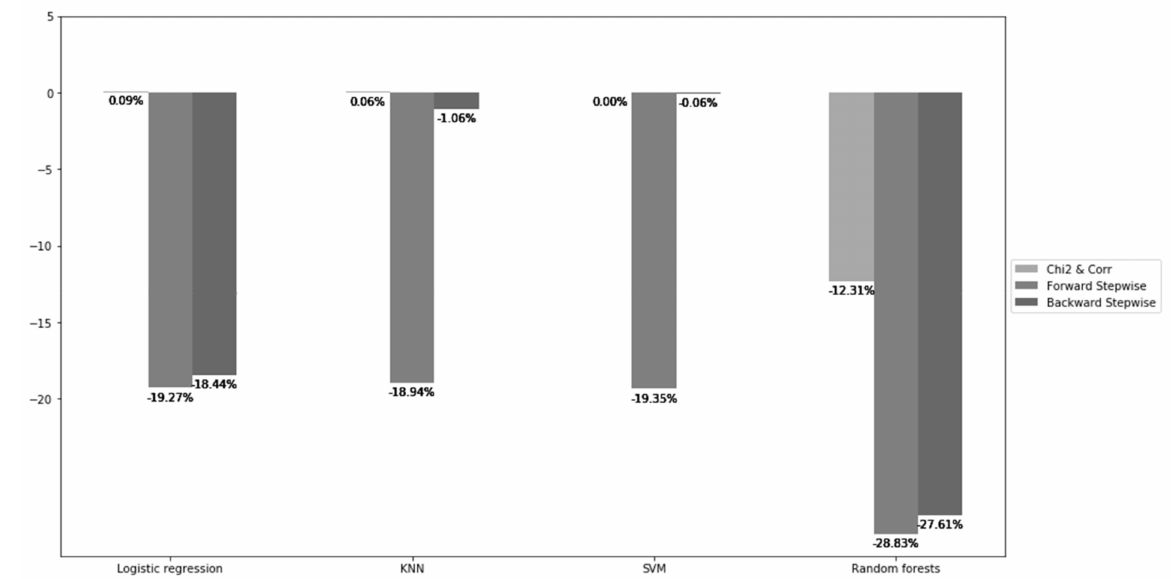
Figure 7. The change in MAE after feature selection.